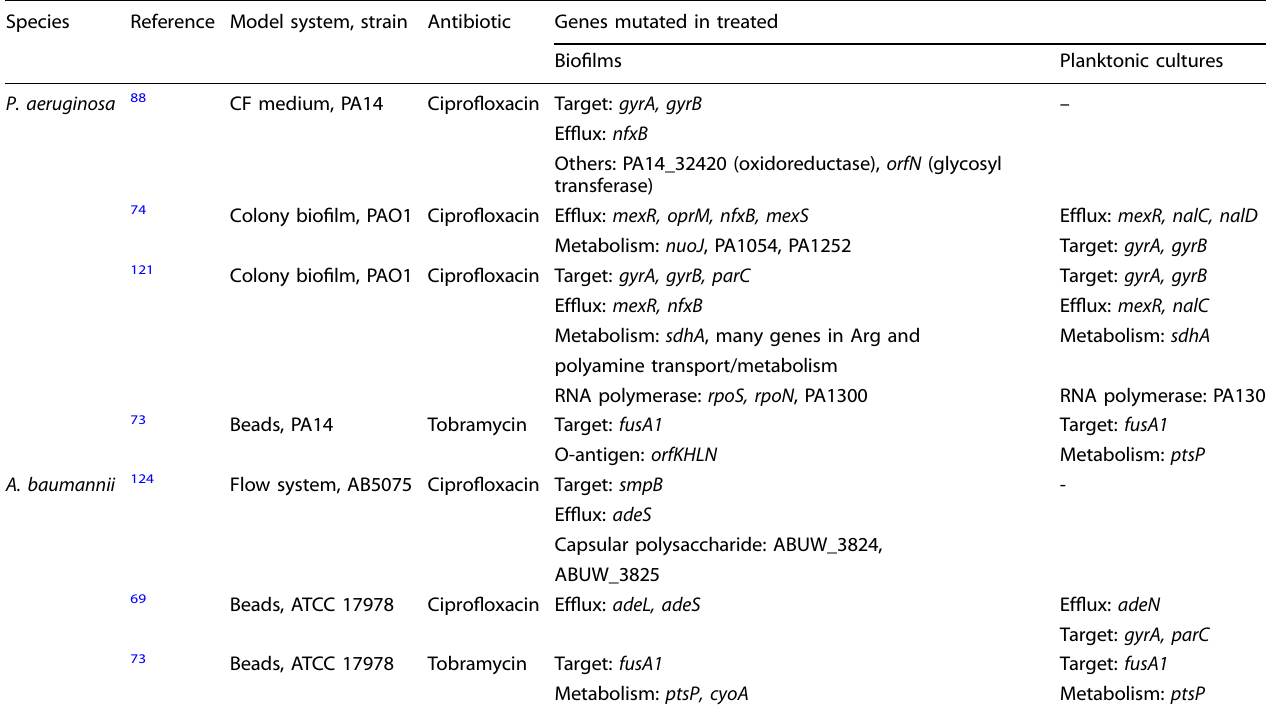
Table 1. Non-exhaustive overview of genes mutated in P. aeruginosa and A. baumannii bio fi lms during experimental evolution in the presence of